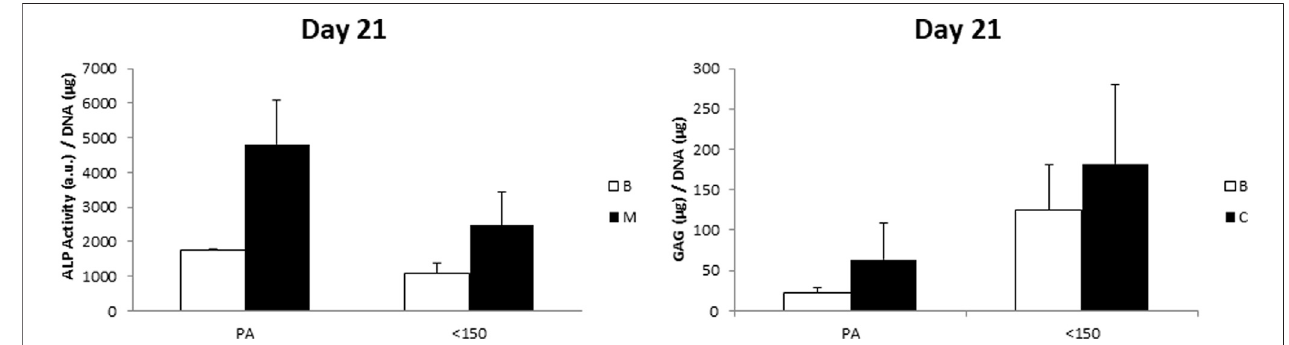
FIGURE6| ALP/DNAandGAG/DNA measured for300/55/45-PVPpastescaffoldssinteredatatemperature lowerthan150 ° C,comparedtosmooth300/55/45 scaffolds (PA). A general enhanced GAG production was observed on 300/55/45-PVP paste scaffolds, which was statistically signi fi cant ( p < 0.05) in basic medium.